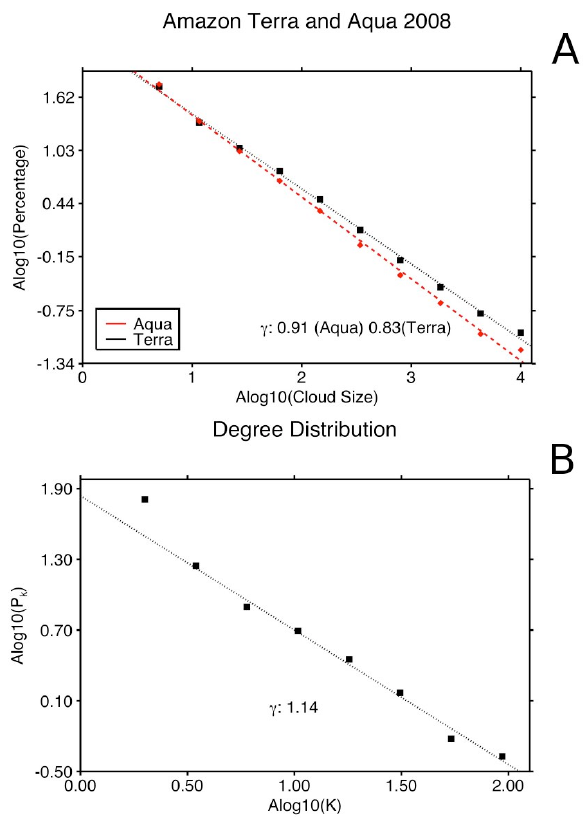
Fig. 3. (A) Cloud size frequency distributions for September 2008 over the clean West Amazon. The two lines are for data from Aqua (in red) and Terra (in black). A more pronounced diurnal variation is noted compared to that over ocean. (B) Degree distributions from the stochastic model run with M = 2, C = 3 and N = 1. We run the model until it has 4000 vertices. The exponent is close to that observed for trade cumuli over the